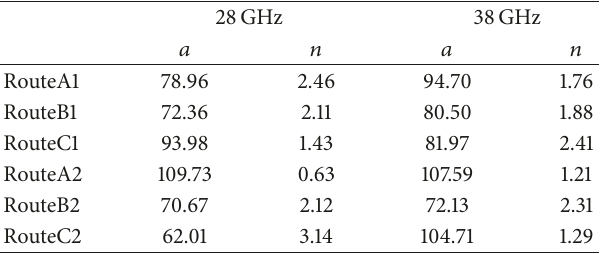
Table 4: Each receive route 𝑎 and 𝑛 in 28 GHz and 38 GHz.